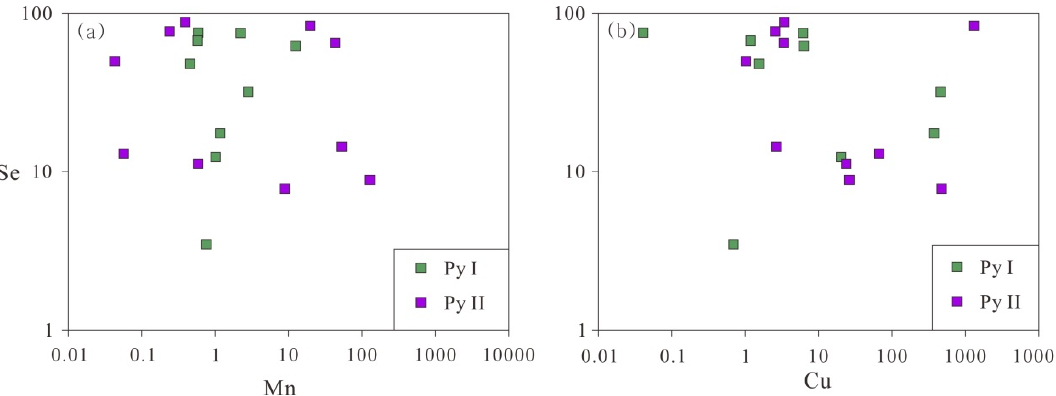
Figure 6. Mn vs. Se diagram ( a ) and Cu vs. Se diagram ( b ) for pyrite from massive and lamellar ores of the Dongguashan copper (gold) deposit.